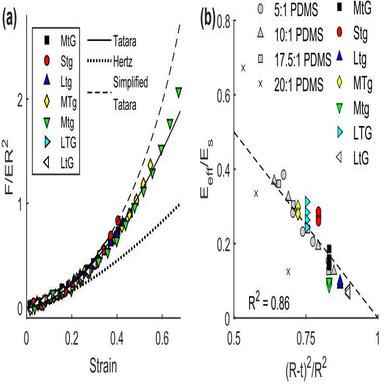
(a) Non-dimensionalized force-displacement data compared to the Hertz and linear Tatara models. (b) Non-dimensionalized elastic moduli and the thicknessto-radius ratios of microcapsules with different percentages of gellan gum.